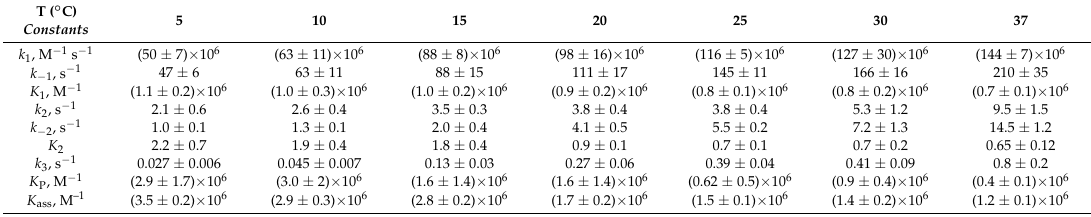
Table 4. Rate and equilibrium constants corresponding to the interaction of Endo III with